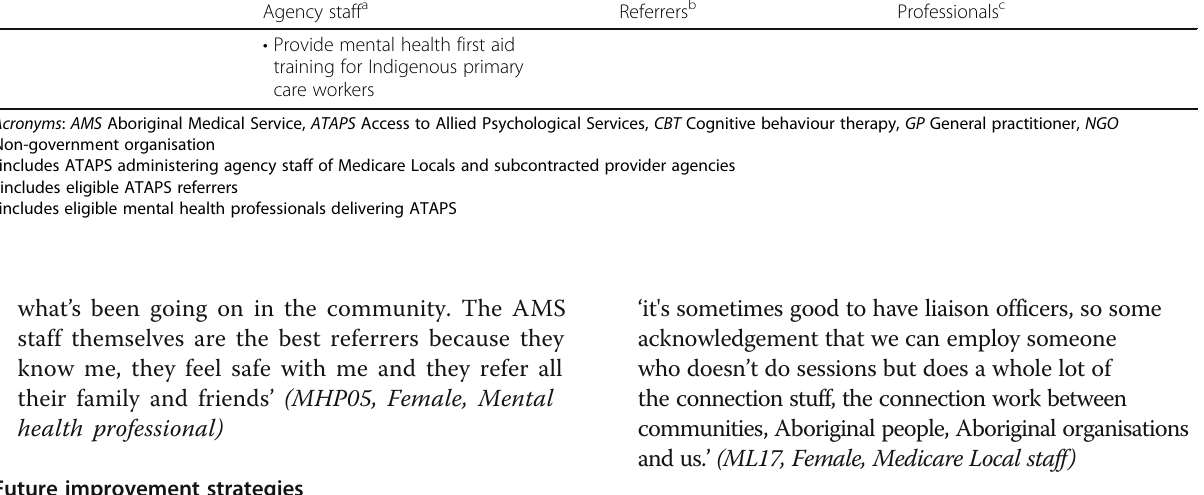
Table 3 Service implementation barriers, facilitators and future improvement strategies (Continued) Agency staff